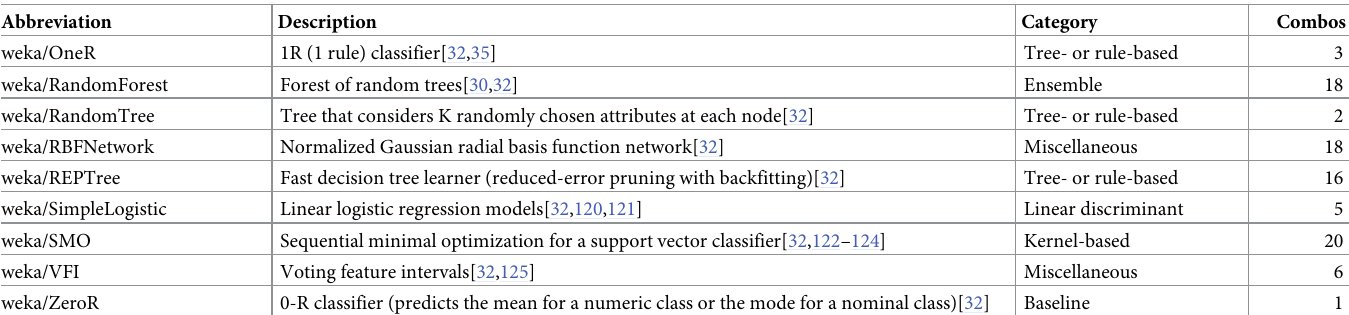
algorithm. S12 Data lists hyperparameters evaluated for these